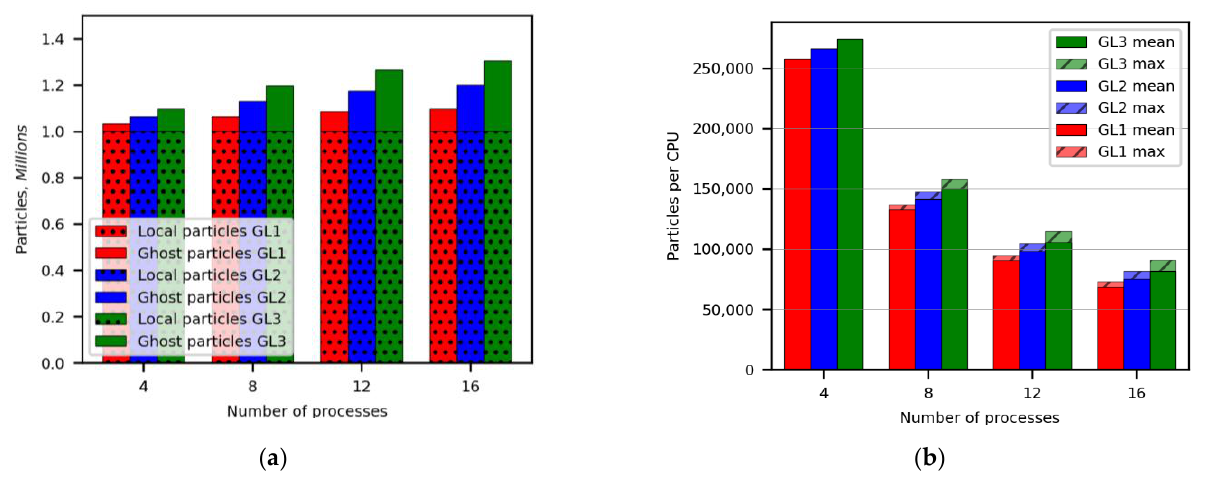
Figure 2. The number of particles owned by a varying number of parallel processes: ( a ) total number of particles and ( b ) varying number of particles per process.